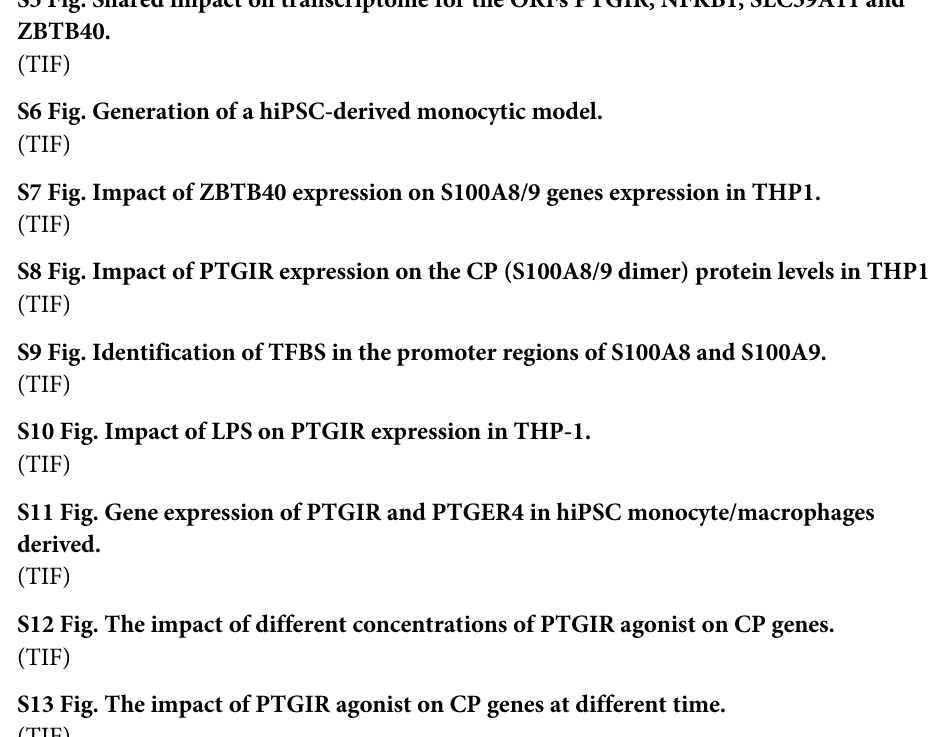
S4 Fig. Shared impact on transcriptome for the ORFs SLC39A11 and NOD2. (TIF) S5 Fig. Shared impact on transcriptome for the ORFs PTGIR, NFKB1, SLC39A11 and ZBTB40. (TIF) S6 Fig. Generation of a hiPSC-derived monocytic model. (TIF) S7 Fig. Impact of ZBTB40 expression on S100A8/9 genes expression in THP1. (TIF) S8 Fig. Impact of PTGIR expression on the CP (S100A8/9 dimer) protein levels in THP1. (TIF) S9 Fig. Identification of TFBS in the promoter regions of S100A8 and S100A9. (TIF) S10 Fig. Impact of LPS on PTGIR expression in THP-1. (TIF) S11 Fig. Gene expression of PTGIR and PTGER4 in hiPSC monocyte/macrophages derived. (TIF) S12 Fig. The impact of different concentrations of PTGIR agonist on CP genes. (TIF) S13 Fig. The impact of PTGIR agonist on CP genes at different time. (TIF) S14 Fig. The impact of different concentrations of PTGIR antagonist on CP genes expres- sion in THP1.